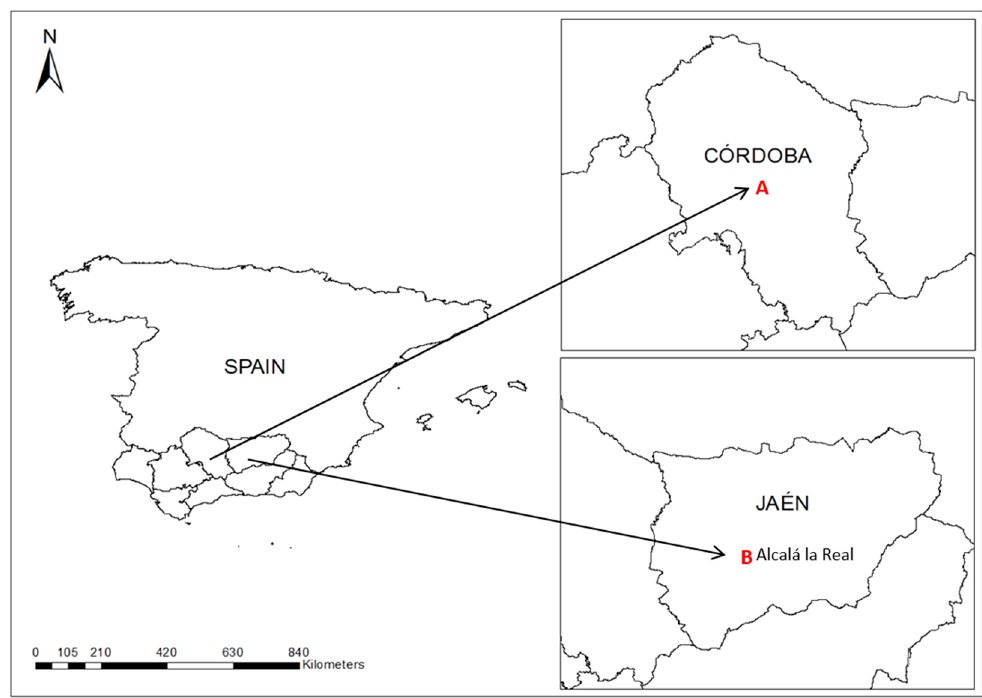
Figure 1. Two Farms in the Southern Spain (A: Farm I. Alameda del Obispo (Córdoba). Brassicaceae grown in Conventional Cropping System; B: Farm II. Ribera Alta. Alcalá la Real (Jaén). Brassicaceae grown in Conventional and Organic Cropping System. The distance between both Farms is 121 km.